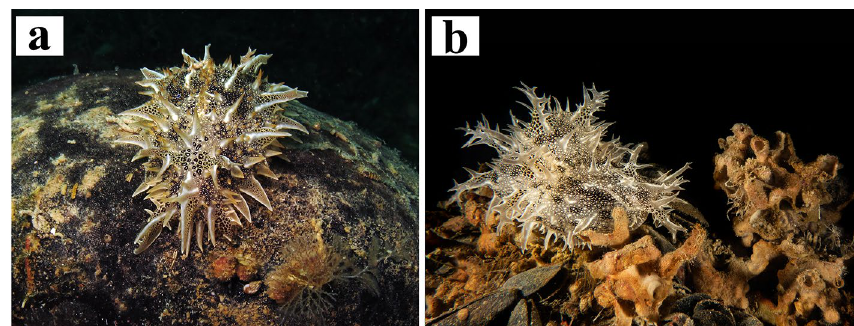
Figure 2. Species objects of the present study. ( a , b ) In situ images of Bursatella leachii